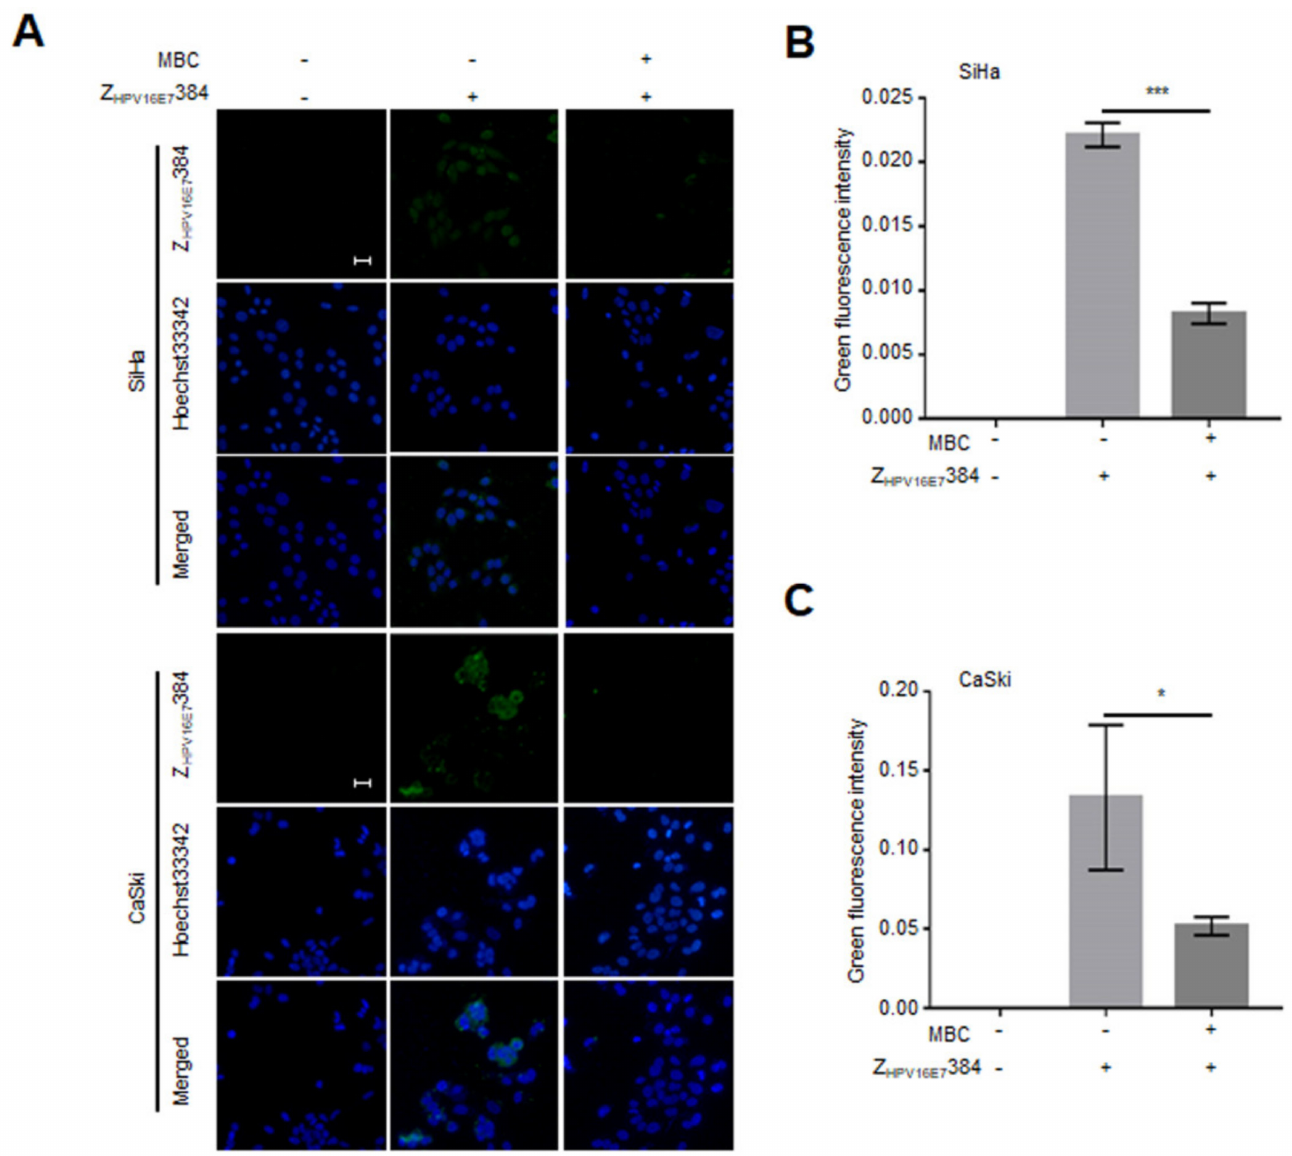
Figure 6. The Z HPV16E7 384 internalization was dependent on caveolin-1. ( A ) The SiHa and CaSki cells that were first treated with the caveolin-1 mediated endocytosis inhibitor MBC and then incubated with Z HPV16E7 384 were analyzed by IFA (green). Cell nuclei were stained with Hoechst33342 (blue). Scale bar = 20 µ m. ( B , C ) The intensity of the green fluorescence in ( A ) was analyzed. The data shown are representative of three independent experiments. All experiments were performed in triplicate and data are expressed as means ± SD ( n = 3). * p < 0.05, *** p <